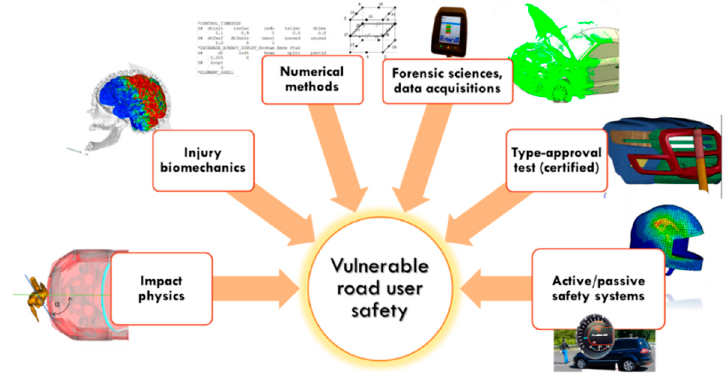
Figure 9. Computer-aided technologies (CAx) for vulnerable road user safety enhancement.